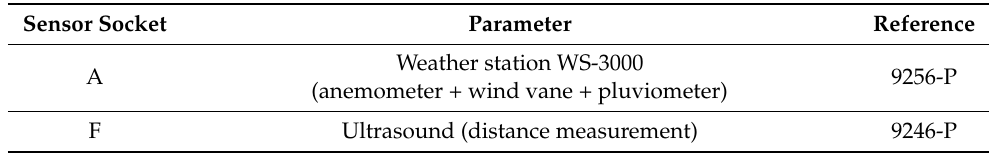
Figure 4. Plug&Sense! Smart Agriculture PRO with all parts connected. Table 1. Sensor sockets